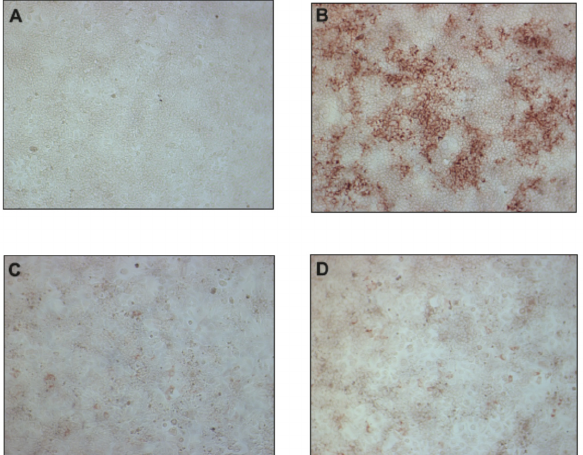
Figure 3. The effect of uridine derivatives of 2 ‐ deoxy sugars (compounds 2 and 4 ) on HCV cc pseudo ‐ plaque formation. Huh ‐ 7.5 cells were infected with HCVcc at an MOI of 0.1 ( B – D ) or mock infected ( A ). At 3 h p.i., the virus was removed and the fresh medium with 50 μ M of compound 2 ( C ) or 4 ( D ) was added. After three days p.i., cells were fixed and pseudo ‐ plaques were detected by immunostaining with anti ‐ core antibody. Molecules 2017 , 22 , x FOR PEER REVIEW